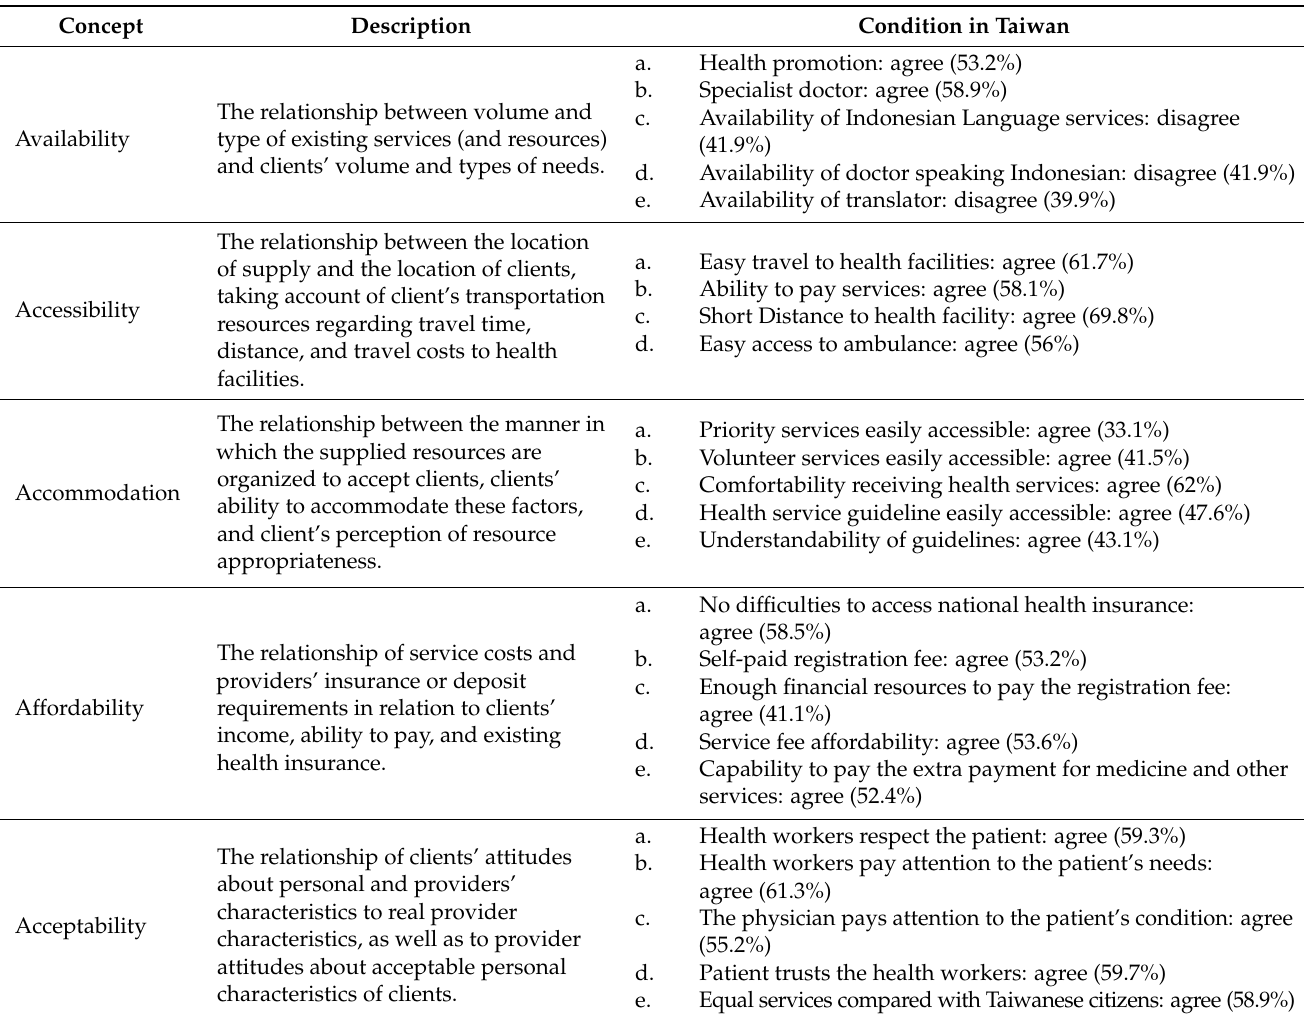
Table 1. The implementation of the 5A concept of access theory in